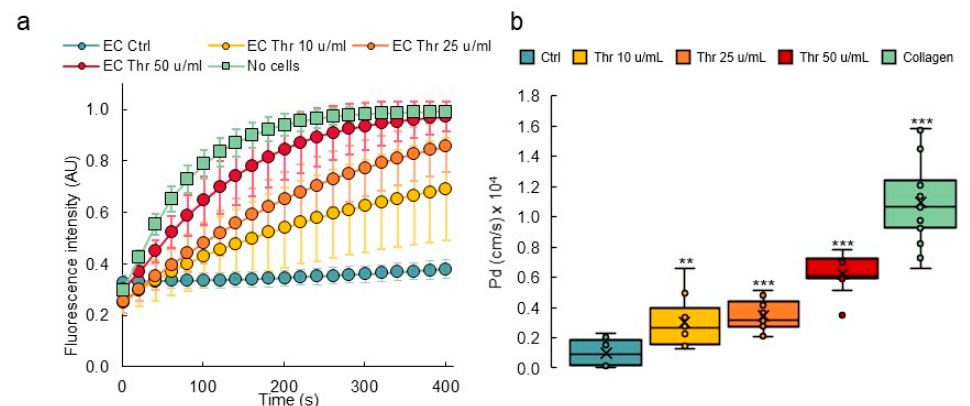
Figure 7. Permeability response of VoC to thrombin. ( a ) Diffusion of 70 kDa dextran-FITC into the collagen layer overtime measured from fluorescent video microscopy movies. EC—endothelial cells; Thr—thrombin. No cells: collagen channels not lined with EC. n = 3 VoC per conditions, 5 regions per vessel were selected to quantify the diffusion, 1 point each 10 s was extracted from the real-time 3 images/s measurements. ( b ) Calculated diffusive permeability coefficients, legend as in ( a ). n = 3 VoC per conditions. Five regions were selected per vessel to quantify the diffusion, ** p < 0.01, *** p < 0.001 when compared to Ctrl. Fifteen VoC were processed at a time in this representative